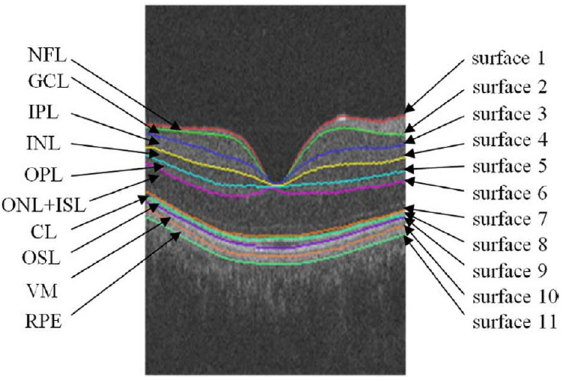
Figure 1. An OCT image including retinal layers and borders 5